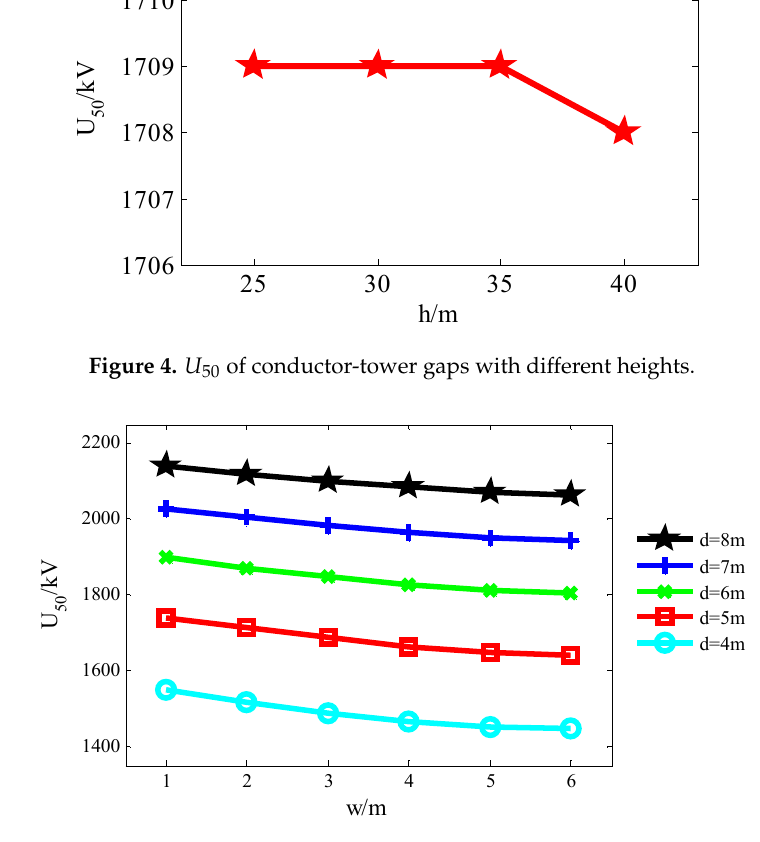
Figure 5. U 50 of conductor-tower gaps with different widths.